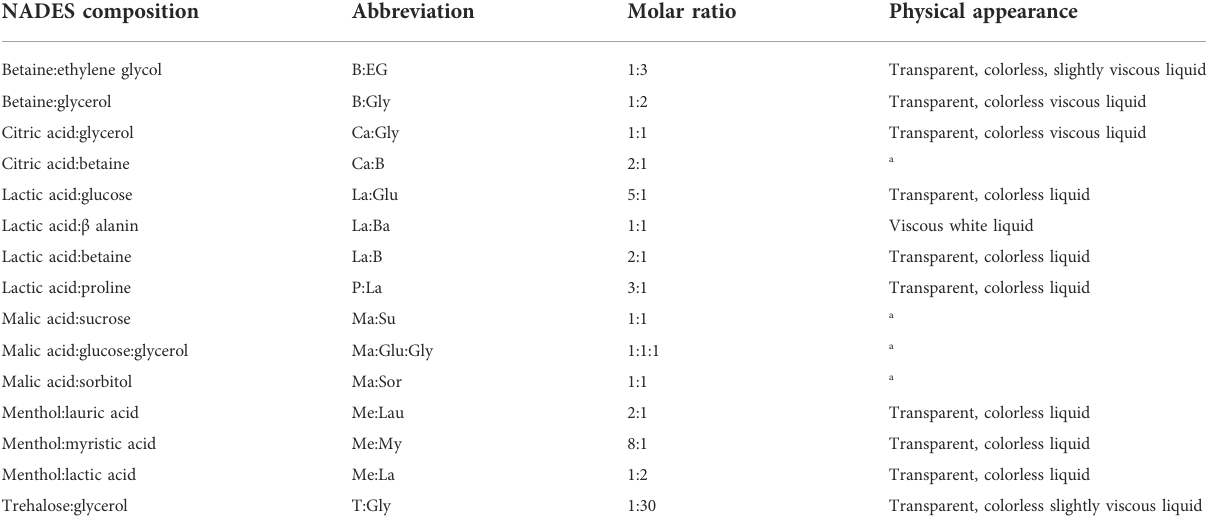
TABLE 1 Composition, molar ratio, and physical appearance of the prepared NADESs. NADES